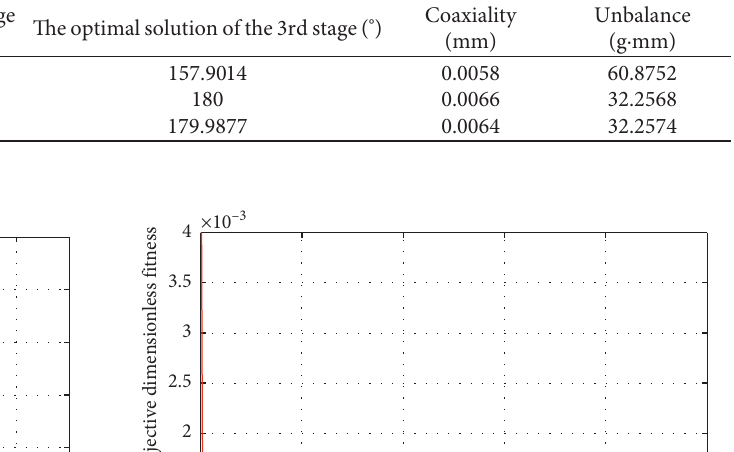
Table 3: The simulation results of the genetic optimization without screw holes.